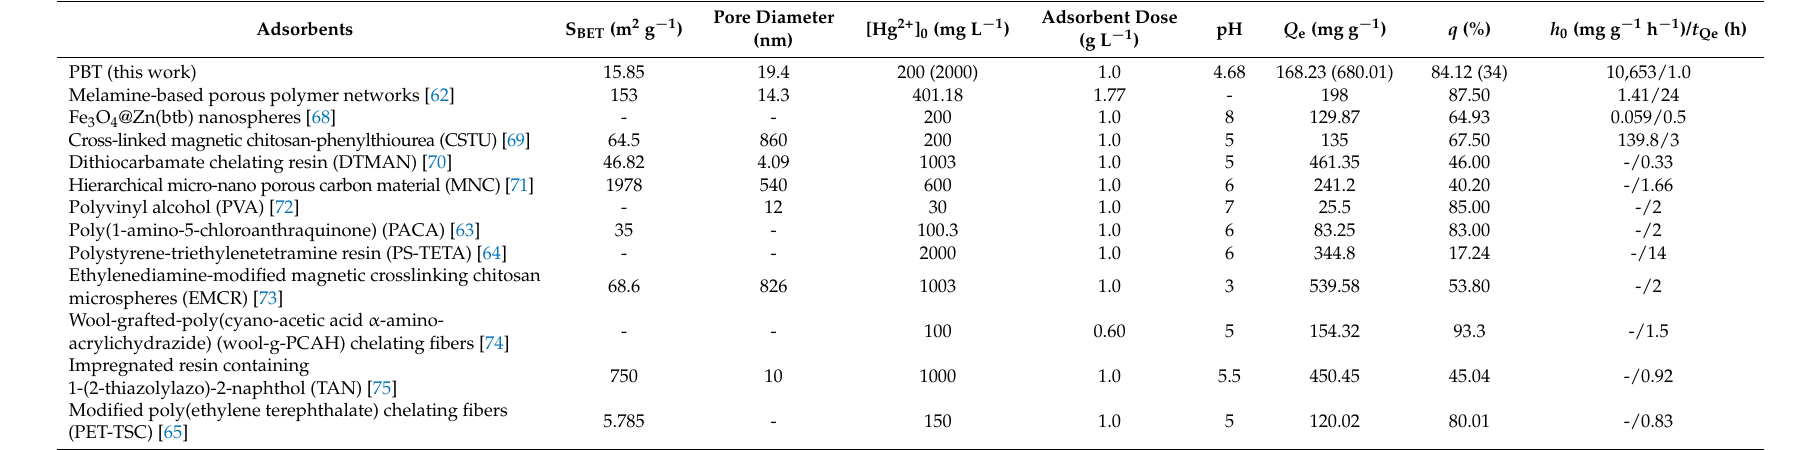
Table 5. Comparison of specific surface area (S BET ), average pore diameter, equilibrium adsorption capacity ( Q e ) and adsorption ratio ( q ), and initial adsorption rate ( h 0 ) of various adsorbents towards Hg 2+